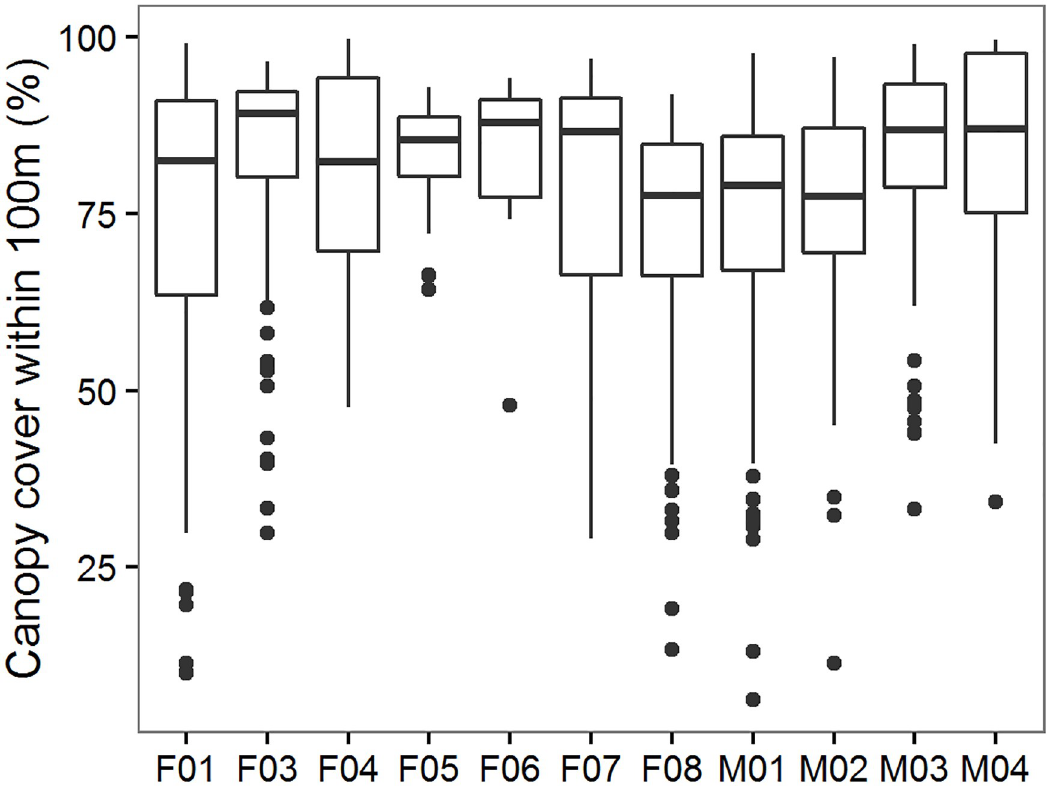
Fig 5. Vegetation data—Humboldt marten fine-scale canopy association. Percent canopy cover (vegetation height > 1 m estimated from LiDAR) within a 100 m moving radius of spatial locations of 11 Humboldt martens ( Martes caurina humboldtensis , x-axis, F = female, M = male) in the Central Coast, Oregon. Data were collected using VHF and GPS telemetry from October 2015 to April 2016 (see methods within [67]). Here, the combination of both overstory and understory cover used by Humboldt martens was high (average median = 81%, range = 64–92%). Box plots show maximum and minimum values (end of lines or extreme points), first and third quartiles (top and bottom line of box), and the median (line within box).